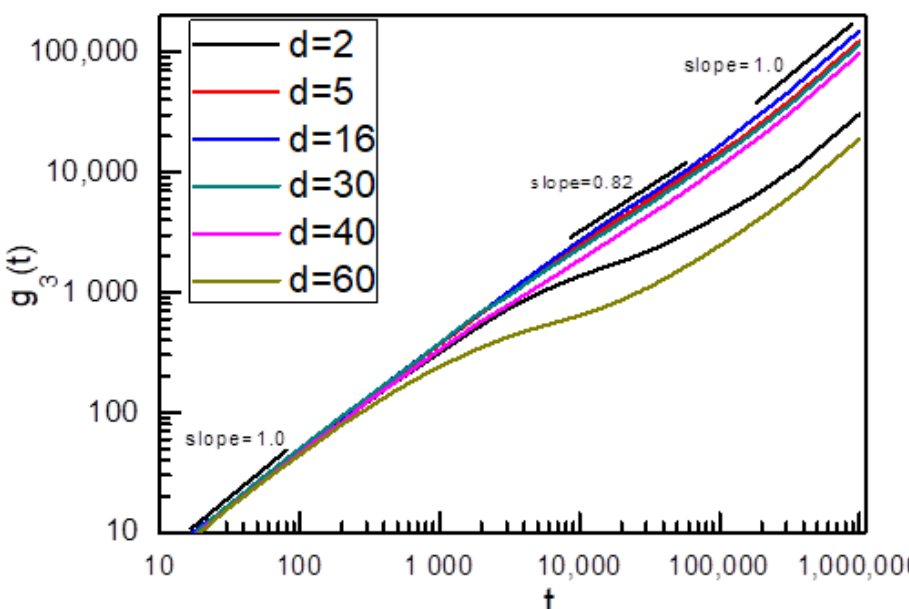
Figure 4. Time dependence ofg 3 (t) of ring chainssliding along the symmetric fluctuating axial chains (K 1 = K 2 = 0) with different distances d between two symmetric fluctuating axialchains. The sliding dynamics could be discussed in terms of diffusion coefficient D, and